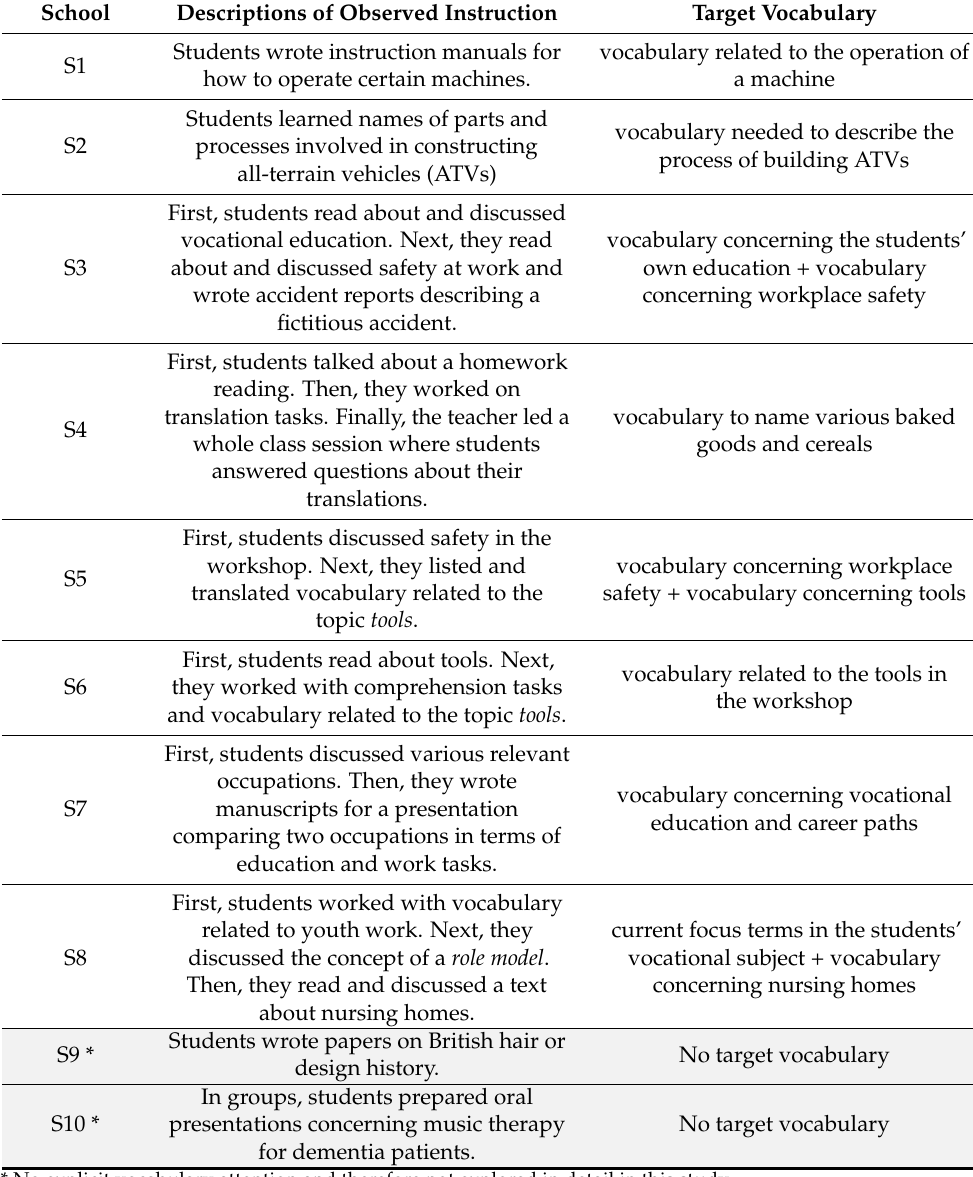
Table 2. A table describing observed instruction in S1–S10 and target vocabulary in